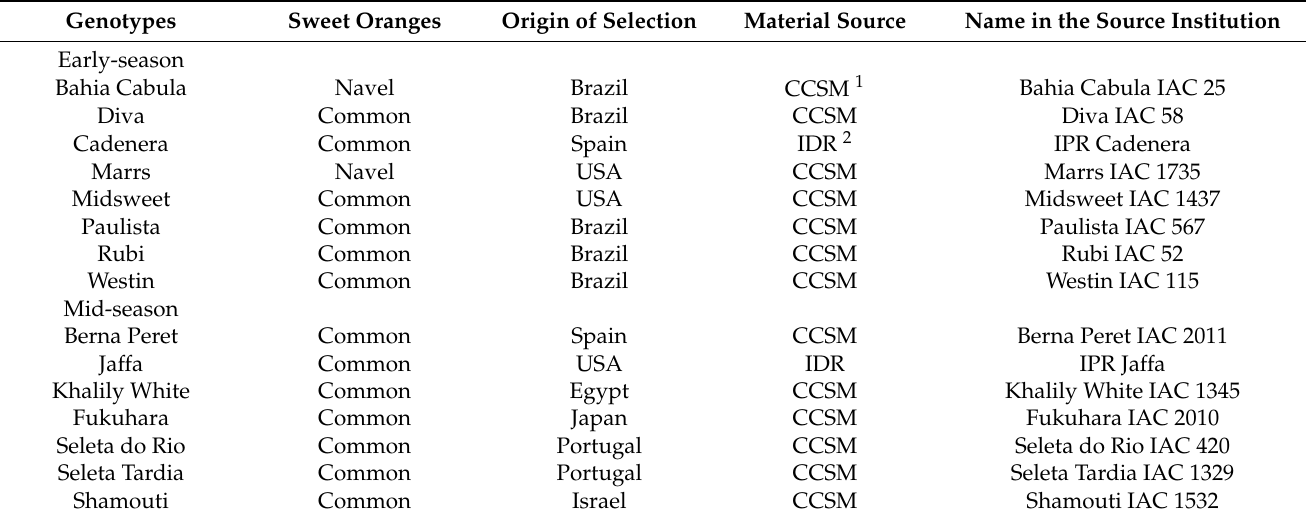
Table 1. Origin of the 15 sweet orange ( C. sinensis (L.) Osbeck) cultivars included in the